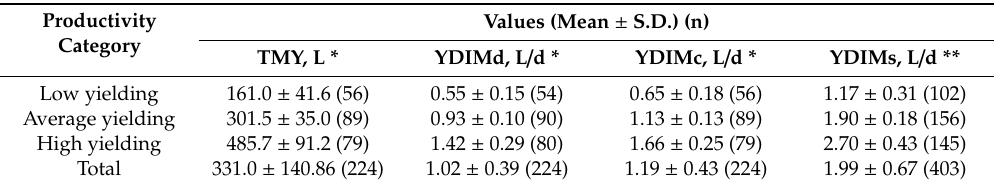
Table 2. Productive parameters of ewes categorized by level of milk yield during the studied lactation and subsequent